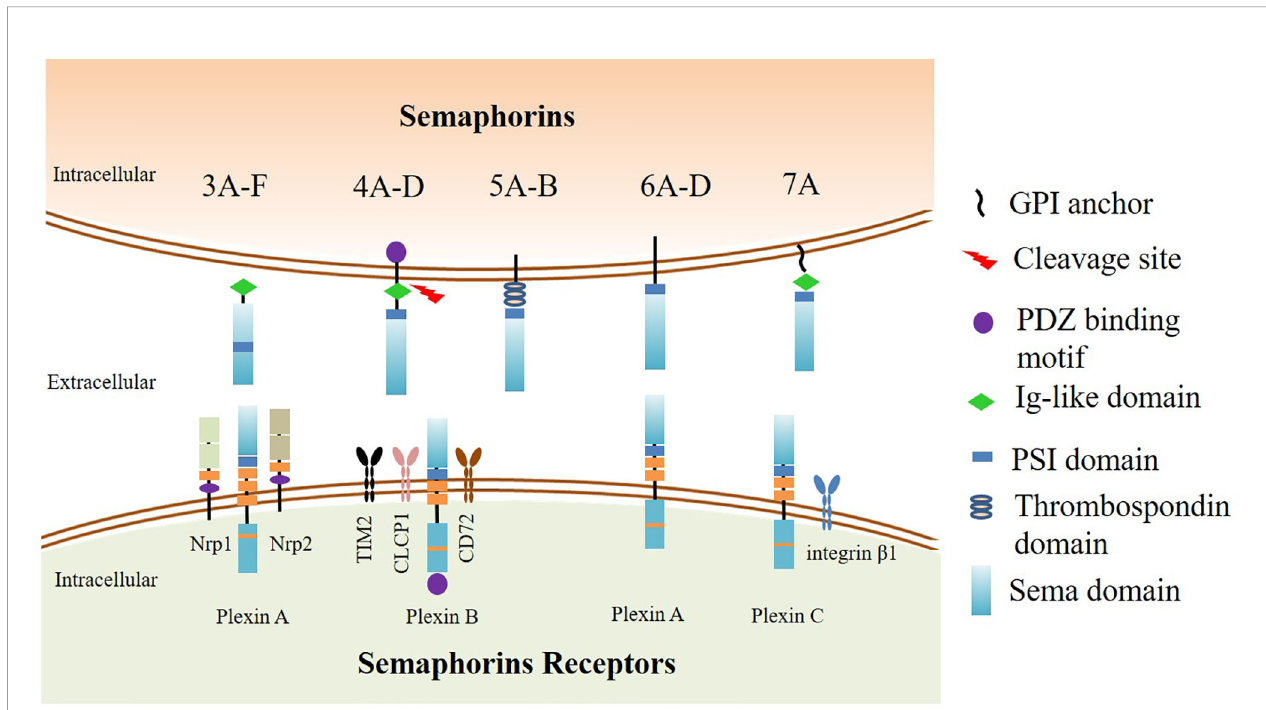
FIGURE 1 | The classi fi cation and structure of semaphorins and their receptors. The upper part: Class 3 semaphorins are secreted proteins. Class 4 to 6 semaphorins are membrane-bound proteins. Sema7A is the only GPI-linked protein in the semaphorin family. The N-terminus of the semaphorins is Sema domain. Adjacent to the downstream area of the Sema domain is the plexin-semaphorin-integrin (PSI) domain. Class 3, 4, and 7 semaphorins contain an immunoglobulin-like domain located downstream to the PSI domain. Class 4 semaphorins have a PDZ binding motif. The lower part: The receptors of semaphorins. The most membrane-bound semaphorins directly bind to conservative plexins, which are classi fi ed into four classes A – D. Plexin A proteins are mainly associated with class 5 and 6 semaphorins, whereas Plexin B proteins are mainly associated with class 4 and 5 semaphorins, and Plexin C proteins are bound with Sema7A. Secreted class 3 semaphorins transmit signals requiring neuropilins (Nrps) as coreceptors. Neuropilins are divided into two subtypes, Nrp1 and Nrp2. There are a few semaphorins that require additional interactors to participate in biological activities. Sema4A binds to TIM2, Sema4B binds to CLCP1, Sema4D binds to CD72, and Sema7A binds to integrin b